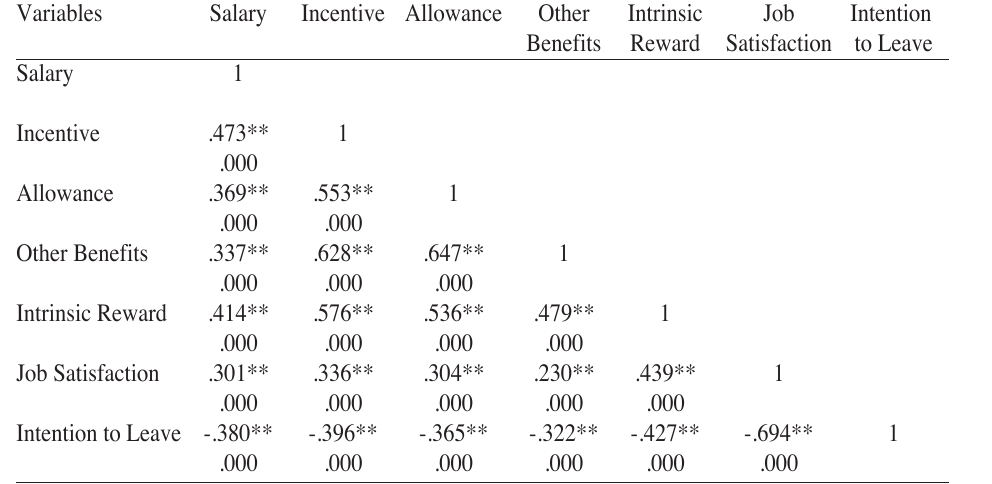
DIndependent, Intervening and Dependent Variables Correlation